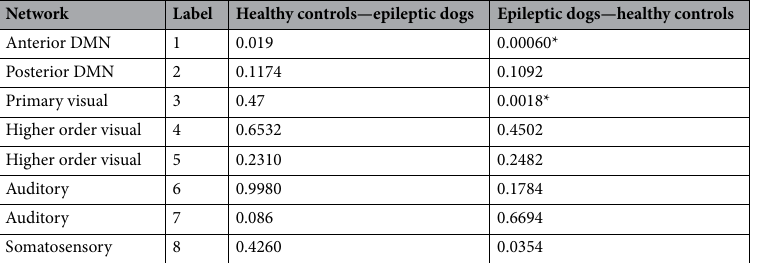
Table 3. Dual regression analysis of independent components for comparison between healthy and epileptic dogs. *Significance set at p < 0.003125 after Bonferroni correction.